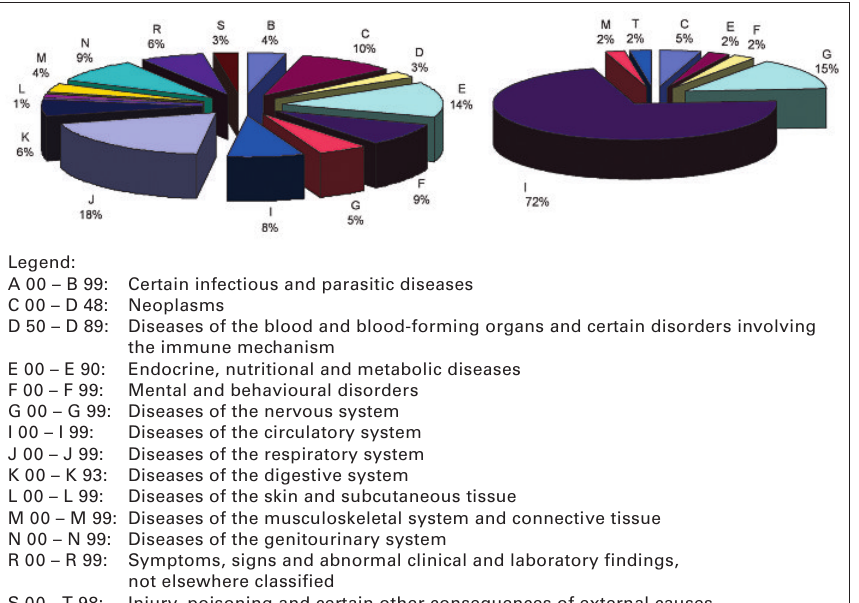
a Distribution of ICD-10 diagnoses of 79 consecutive patients presenting to the ED with generalised weakness . (pneumonia J18.9, acute renal failure